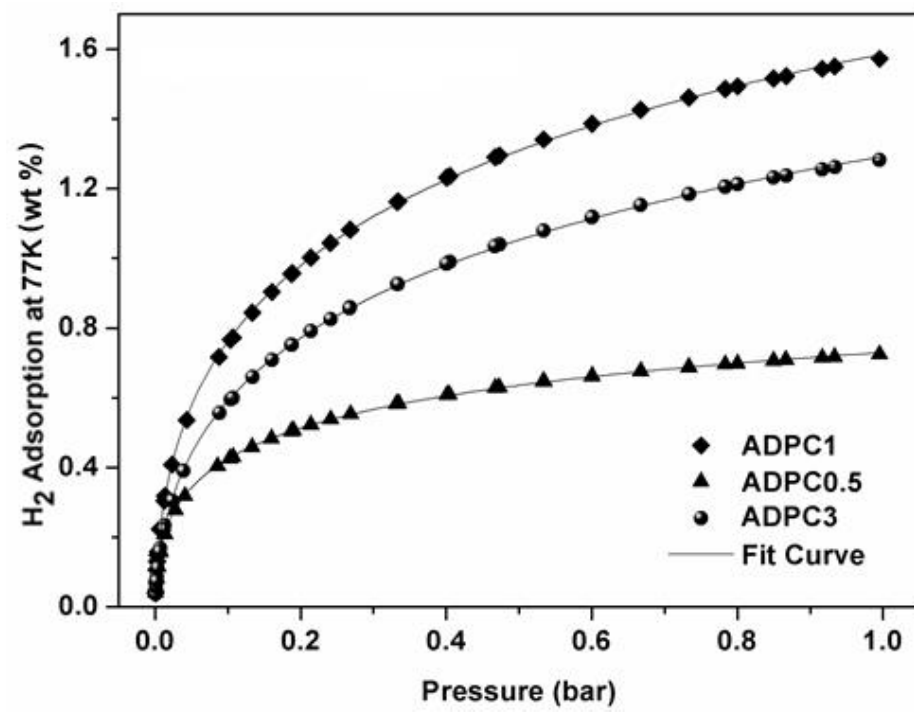
Figure 7. H 2 adsorption isotherms at 77 K up to 1 bar.